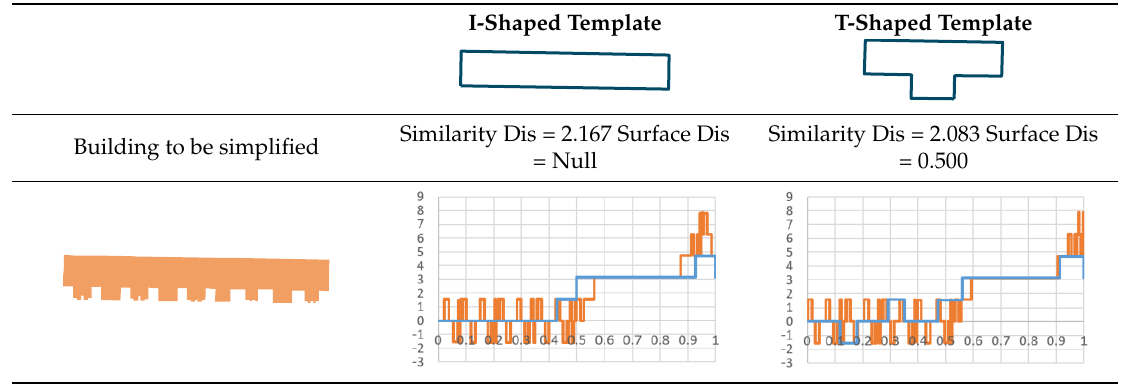
11 of 16 Figure 9. Example for each type of error: ( a ) the first type of error, ( b ) the second type of error, and ( c ) the third type of error. The first type of error is what might have been expected because some building polygons are usually quite large and have complicated shapes, such as built-up areas, and, as a result, many of them cannot find a suitable template. For example, we did not create a special template for the complicated building in Figure 9a, thus, it failed to be simplified. For the second and third types of error, through in-depth analysis we found that although the turning function and least squares methods performed well, there still exists something unsatisfactory in the simplification, such as that for the one located in the south-west of Figure 6a which is falsely matched as a T-shaped template. To gather more detailed information, we chose two templates (a T-shaped template that matched in the experiment and an I-shaped that may be better matched) to test the southwest one, and the results are shown in Table 2. As we can see, the turning function of the building has a large amount of